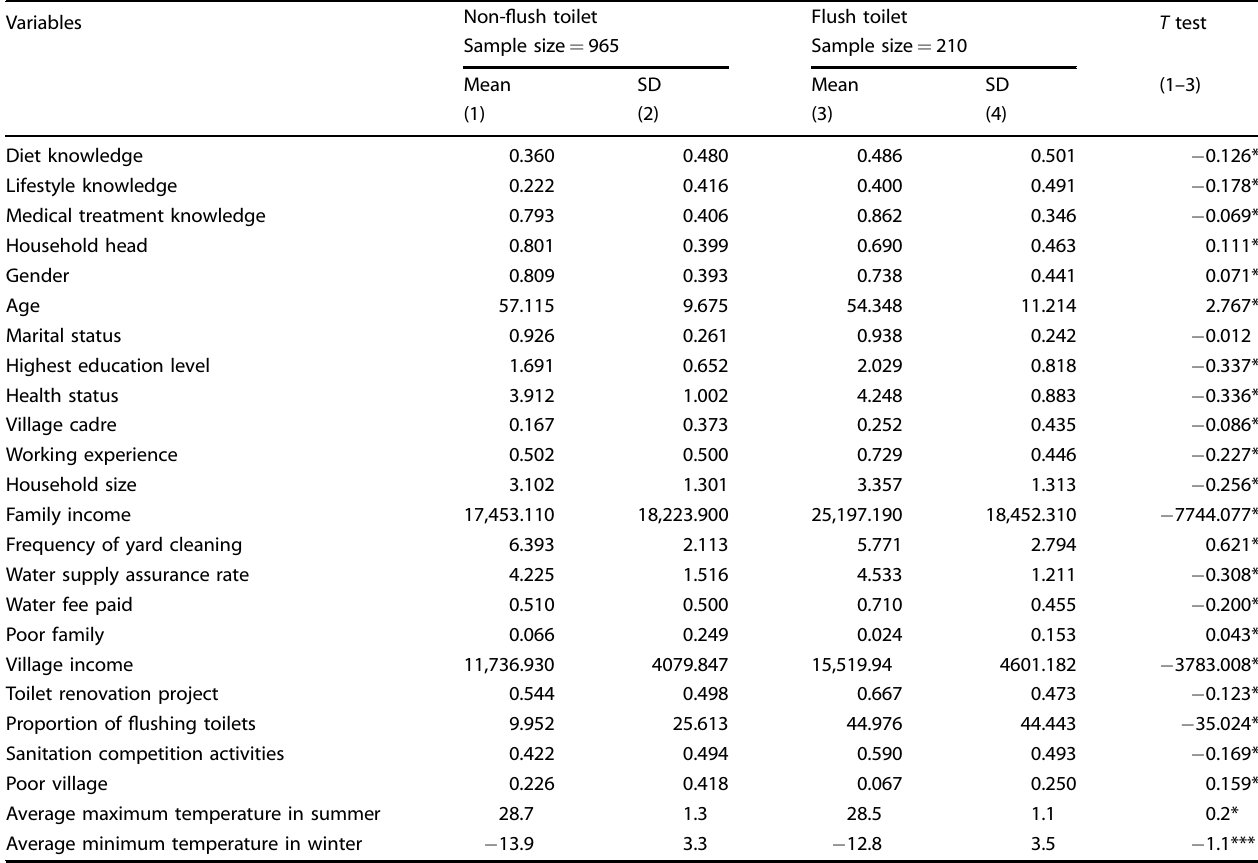
Table 3. T test results between respondents who use fl ush toilets and non- fl ush